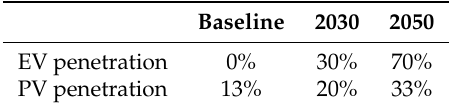
Table 1. EV and PV figures for the penetrations